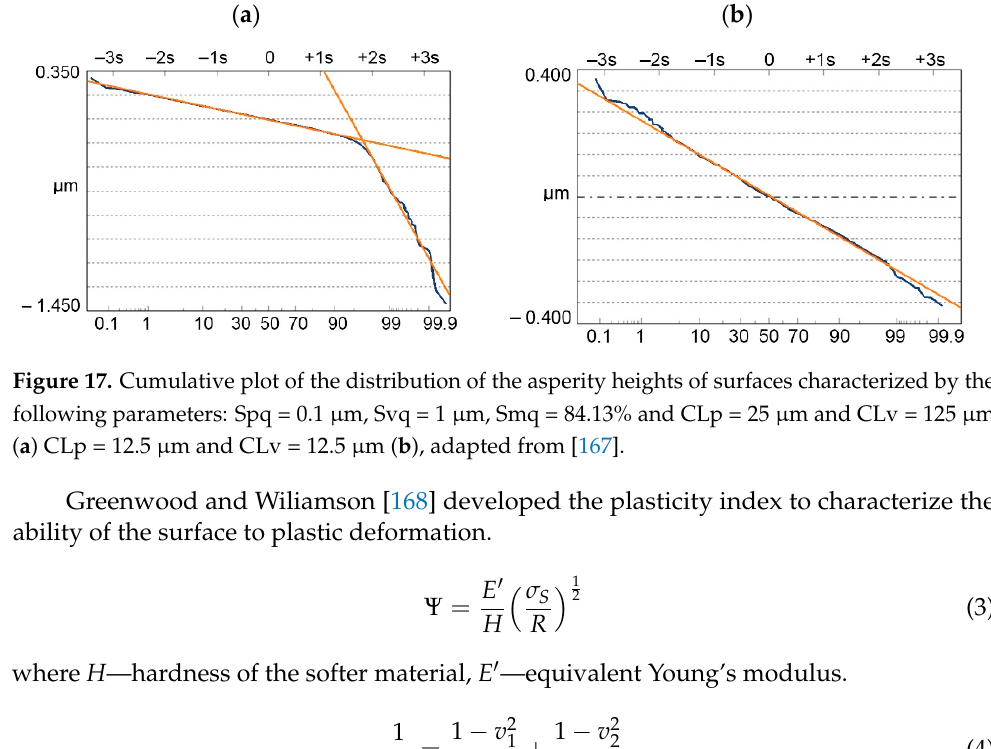
Figure 16. Cumulative probability distribution of the ordinate heights (a) and the heights of the summits (b), adapted from [165].